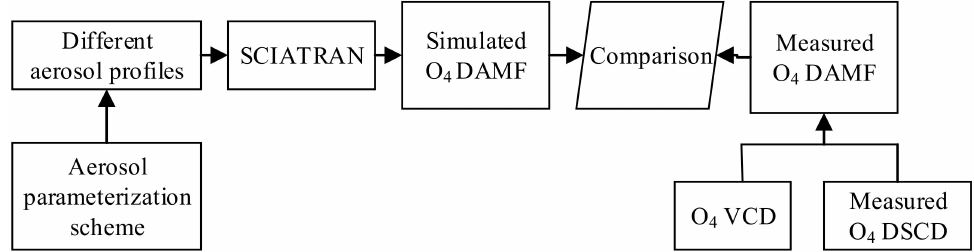
Figure 5. Flow diagram of aerosol optical properties retrieval using a lookup